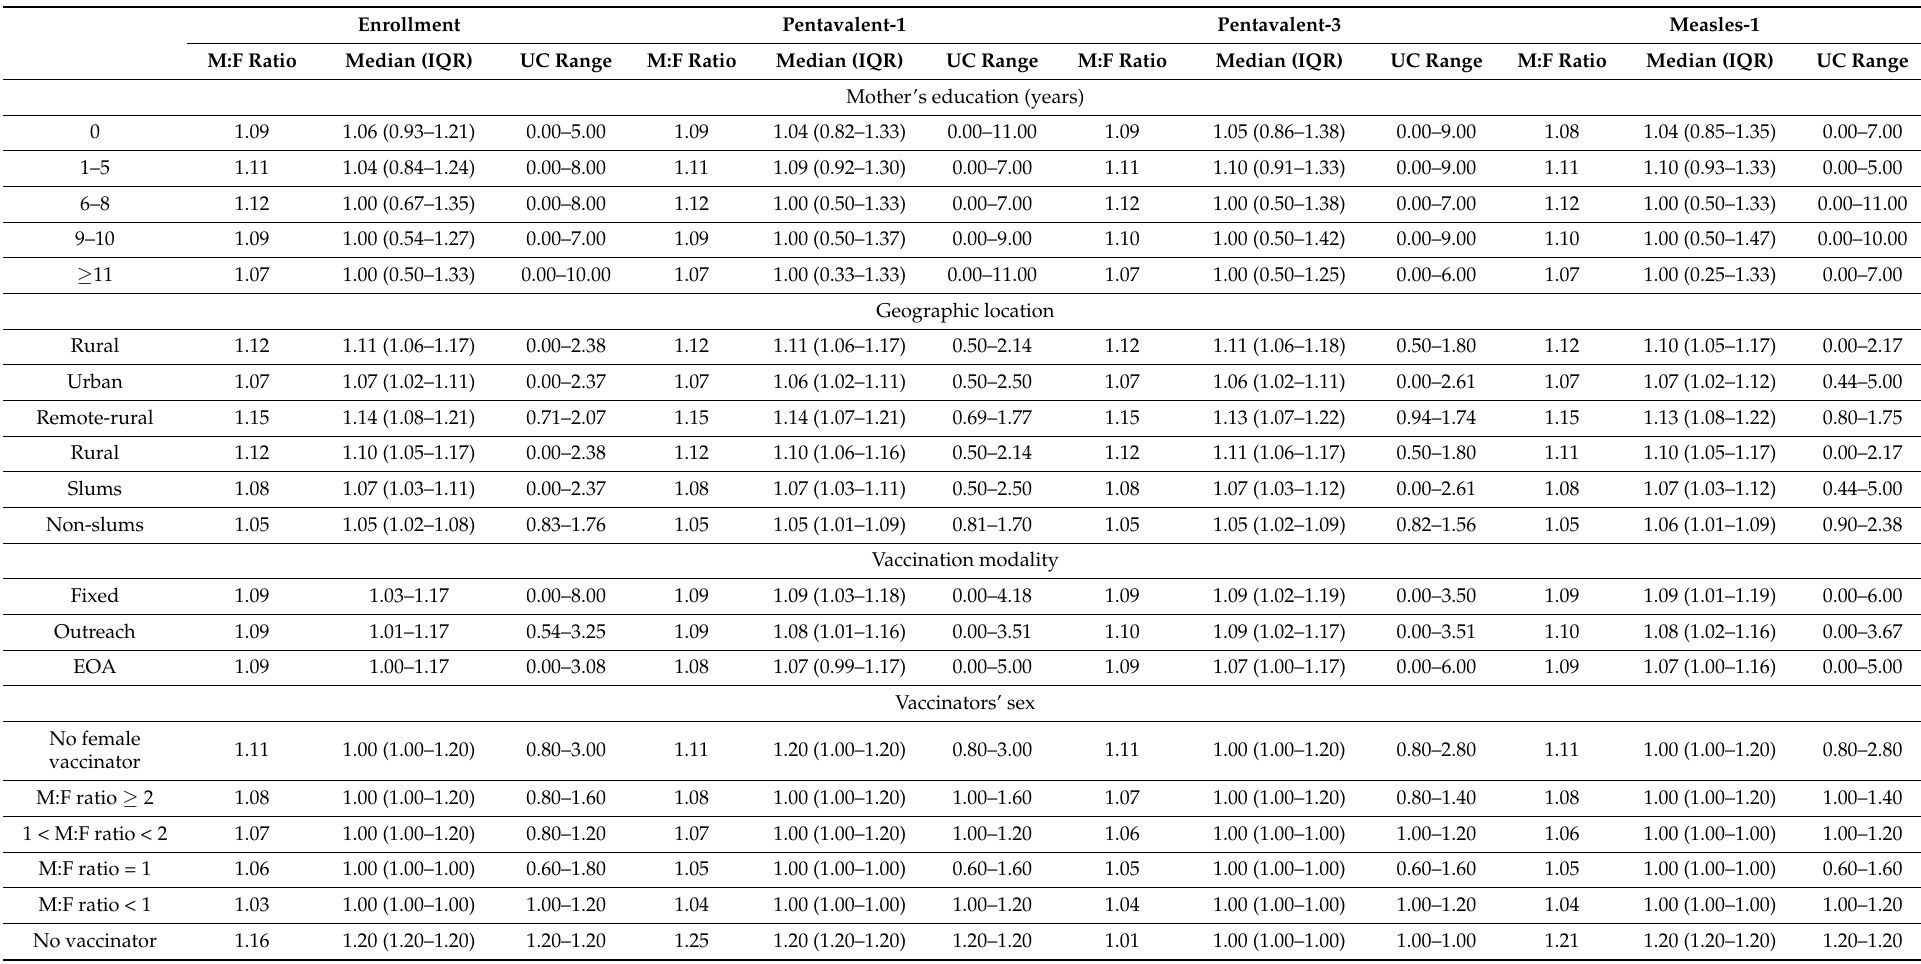
Table 2. Male-to-Female ratios of 0–23-month-old children in 2019–2022 birth cohorts enrolled in SEIR in Sindh Province, Pakistan, by maternal literacy levels, geographic profile, vaccination modality, and vaccinator sex ratio at enrollment for Pentavalent-1, Pentavalent-3 and Measles-1 vaccines ( n = 6,235,305) (1